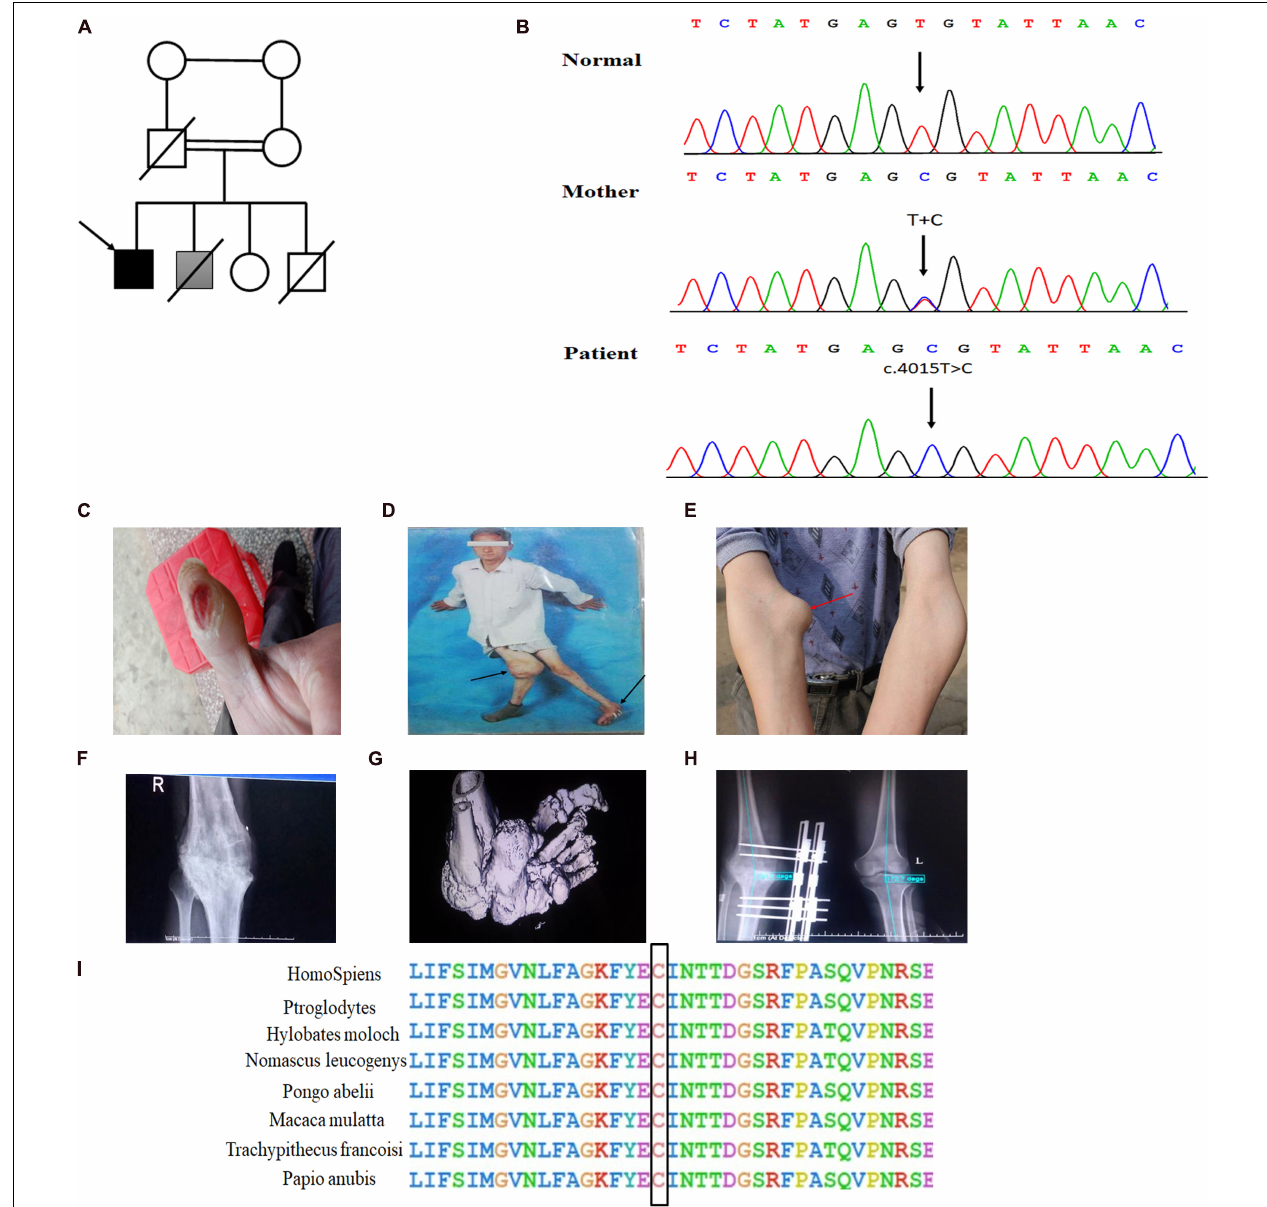
FIGURE 1 | Novel homozygous SCN9A mutation and the clinical phenotypes in the proband with Charcot neuroarthropathy. (A) Family pedigree. The proband is indicated by a black arrow. The shaded box represents a suspect patient who is presented with Charcot neuroarthropathy. The genetic relationship of parents is them being first cousins. (B) DNA sequence electropherograms demonstrating c.4015T > C (p. Cys1339Arg) homozygous mutation in the proband. (C) Burns on the finger by a lit cigarette. (D,E) Arrows of different colors represent swollen and deformed joints. (F) Plain radiographs of the right knee joint showed narrowing of the right knee joint space, blurring of the joint surface, bone destruction, and uneven density. The knee is swollen, distorted, and painless. (G) The three-dimensional CT of the left foot showed that the structures of the left ankle joint, the left tarsometatarsal joint, and the intertarsal joint were disordered, and the left ankle showed varus and subluxation. (H) The postoperative x-ray examination of bilateral knee joints showed that the internal fixation device was in place after the correction of the valgus of the right knee. (I) Conservation of residues Cys1339 among different